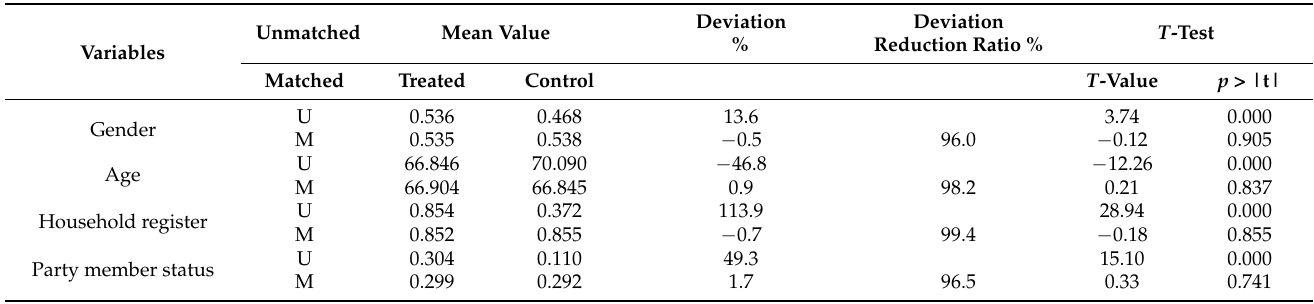
Table 4. Covariates balance testing for propensity score